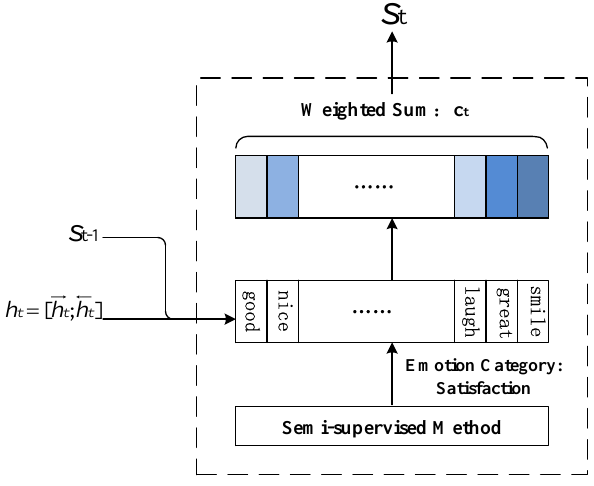
Figure 2. The Dictionary-based Attention Mechanism.